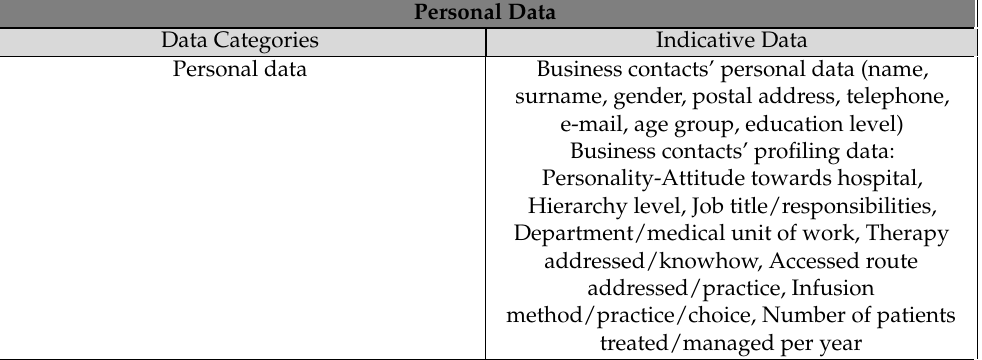
Table 4. Data processed under business development.